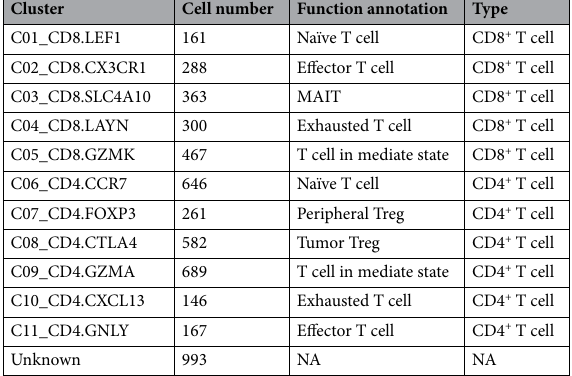
Table 1. Annotation about cell clusters in HCC datasets.